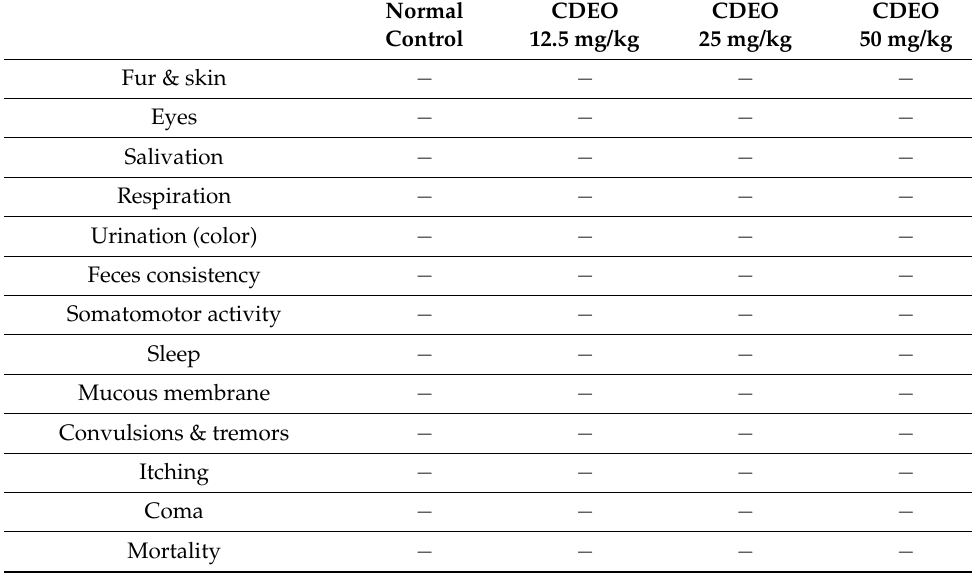
Table 2. Behavioral parameters of the studied